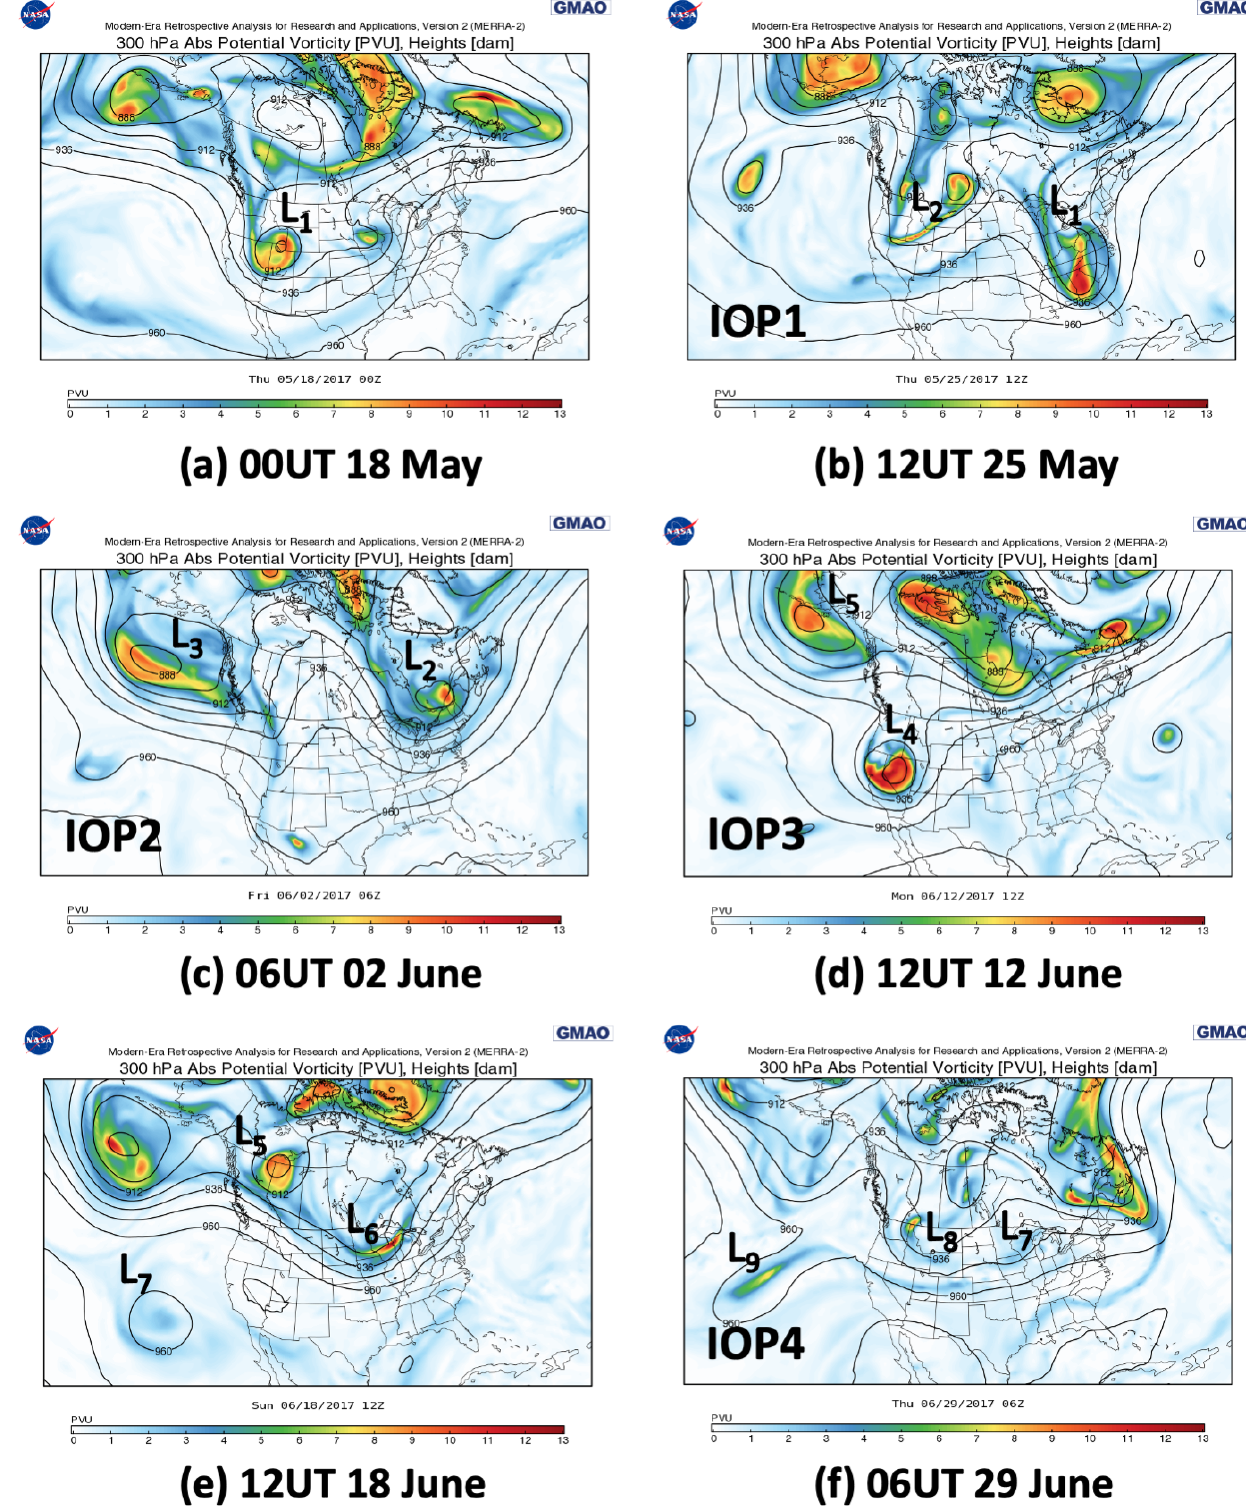
Figure 3. MERRA-2 300hPa Absolute potential vorticity and geopotential heights (dam) at (a) 00:00UT 18 May, (b) 12:00UT 25 May, (c) 06:00UT 2 June, (d) 12:00UT 12 June, (e) 12:00UT 18 June, and (f) 06:00UT 29 June.